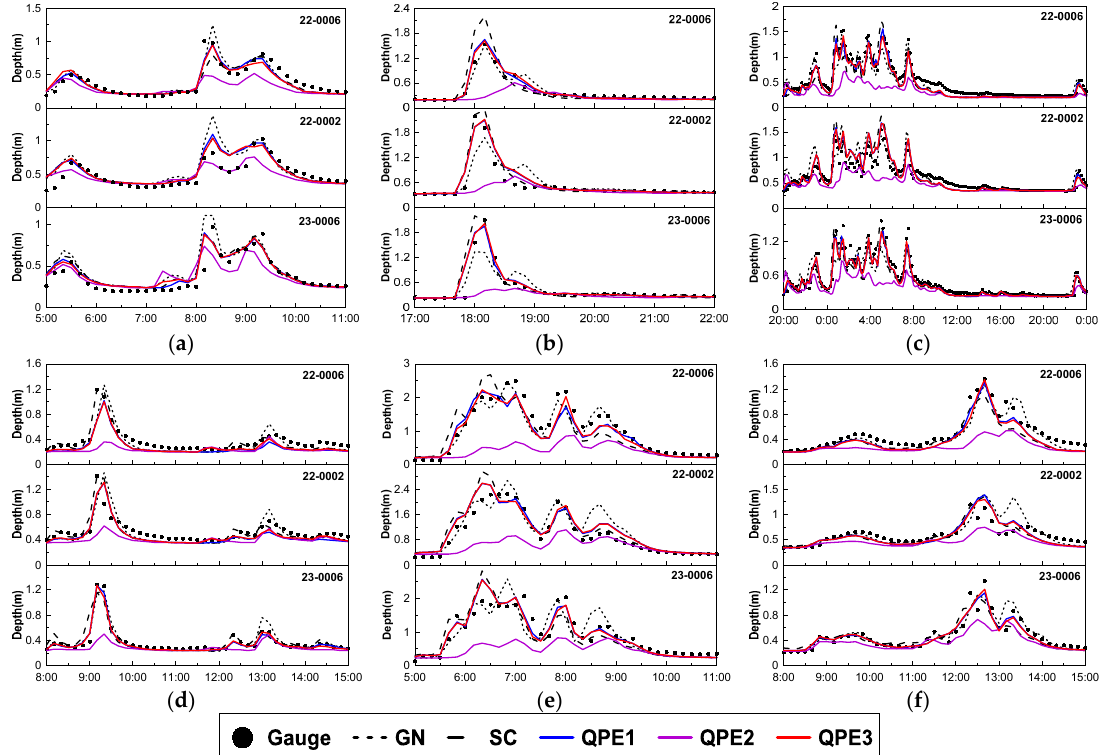
Figure 7. Comparisons between observed and simulated depths in manholes: ( a ) 2 July 2013; ( b ) 4 July 2013; ( c ) 12–14 July 2013; ( d ) 15 July 2013; ( e ) 22 July 2013; ( f ) 23 July 2013.